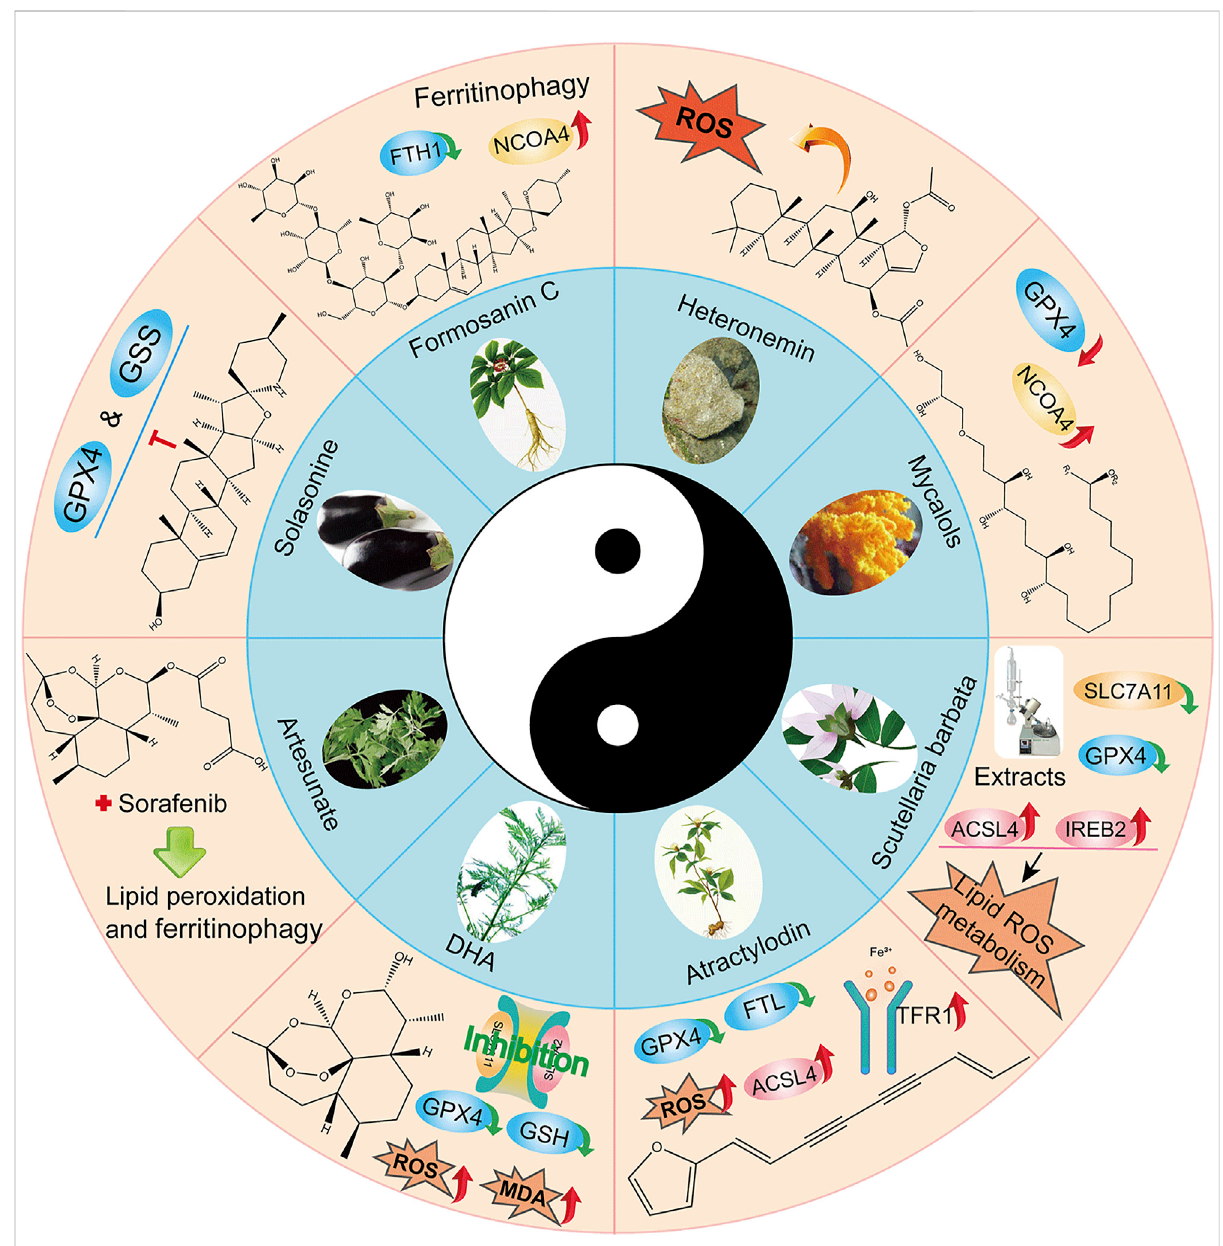
FIGURE 3 ApplicationofChinese medicineintheinduction ofHCCferroptosis. TraditionalChinese medicine: Formosanin